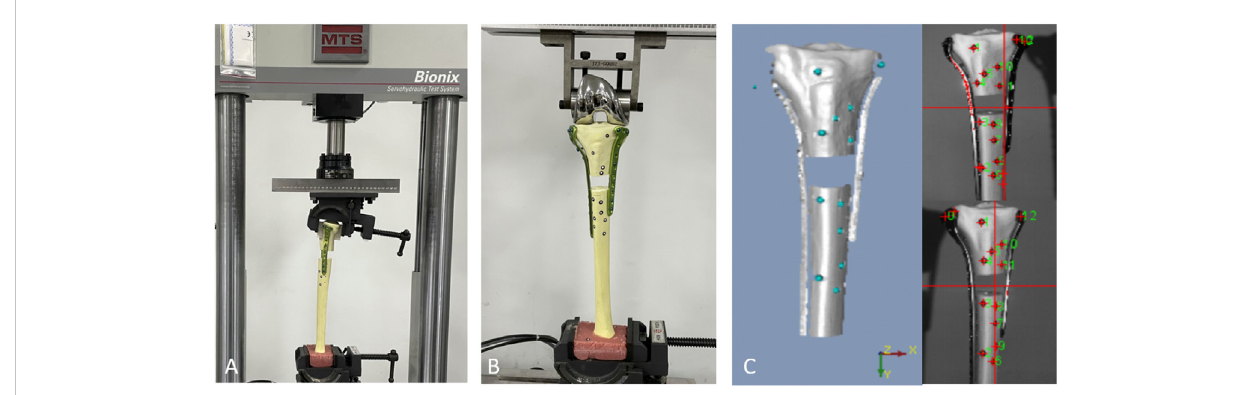
FIGURE 2 A biomechanical machine was used for torsional testing, (A) and a 3D-printed mold was used to fi x the proximal fragment. (B) In the axial compression and cyclic loading test, the load was applied axially through the femoral component of a knee prosthesis. (C) The test setup showed the position of the optical measurement system